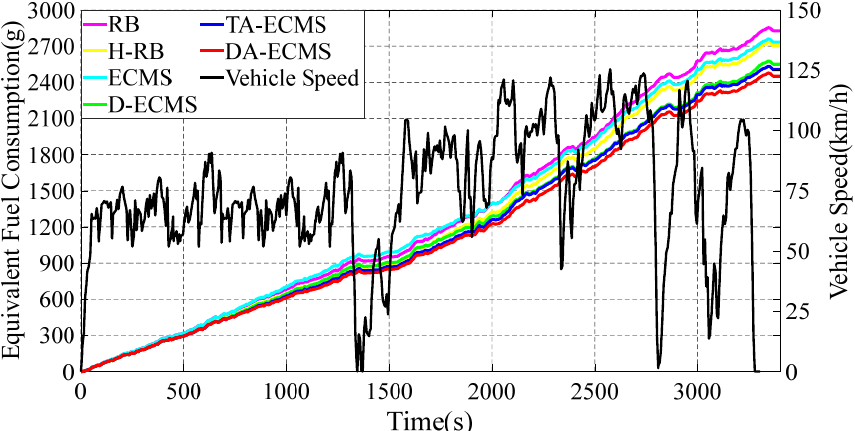
Figure 12. Variation curves for the vehicle speed and the equivalent fuel consumption under different strategies.